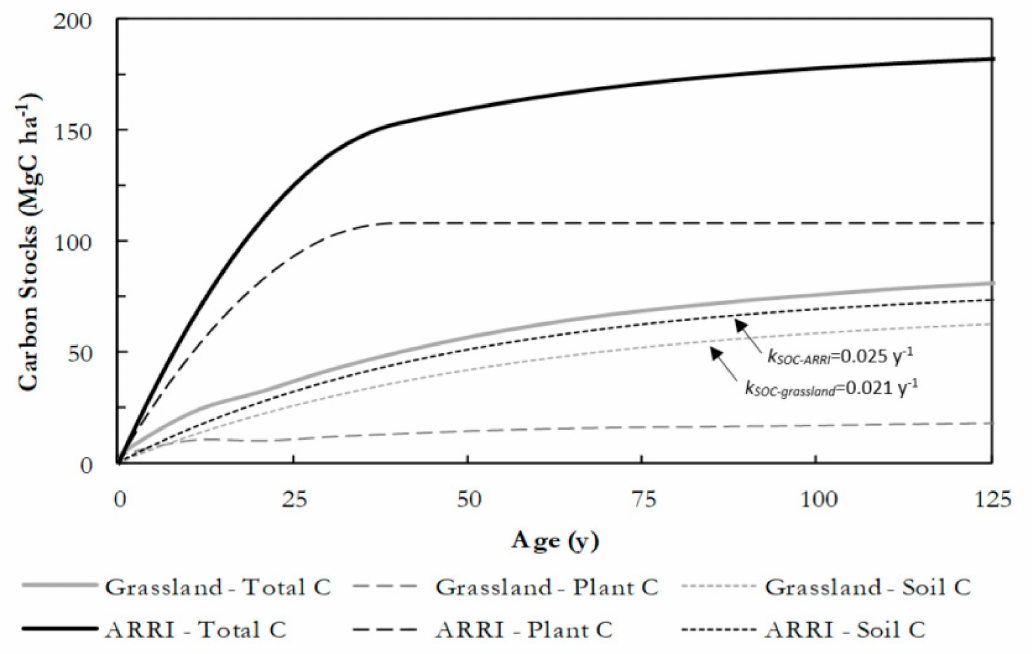
Figure 9. Simulated carbon storage on reclaimed mountaintop mining land as a function of time since reclamation for grassland reclamation (grey lines) and ARRI reforestation reclamation (black